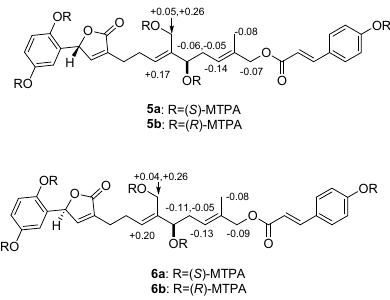
Molecules 2020 , 25 , x Figure 4. Δδ ( S - R ) values for the the Mosher’s esters of 5 and 6 in pyridine- d 5 . Figure 4. ∆ δ ( S - R ) values for the the Mosher’s esters of 5 and 6 in pyridine- d 5 .